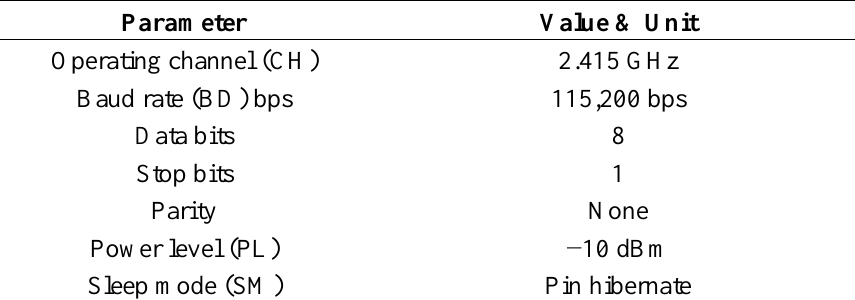
Table 1. Configuration of sensor and coordinator nodes based on X-CTU